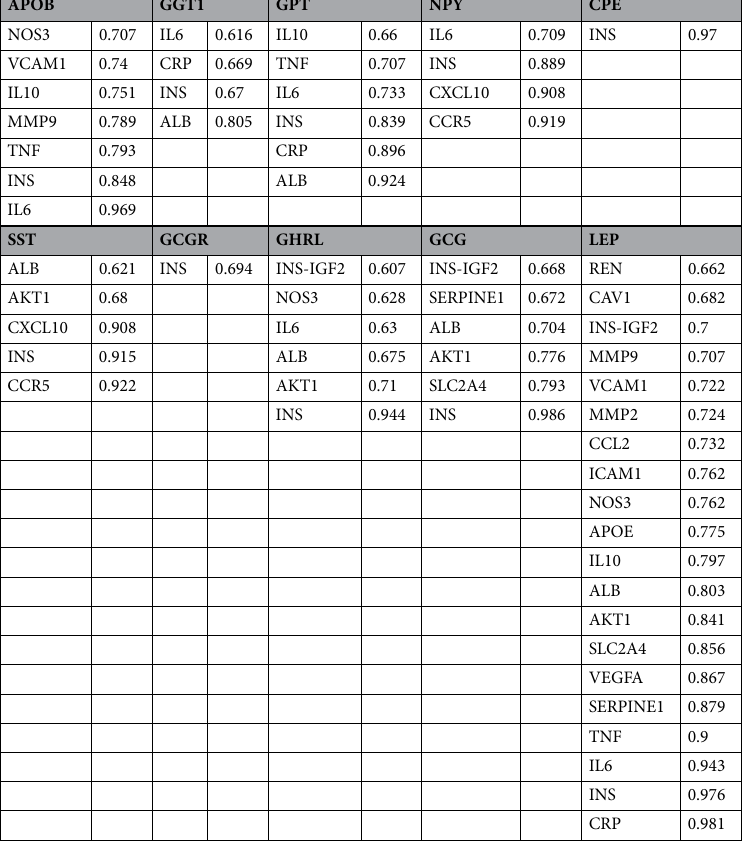
Table 3. Module 1 cross module associated protein and relevance